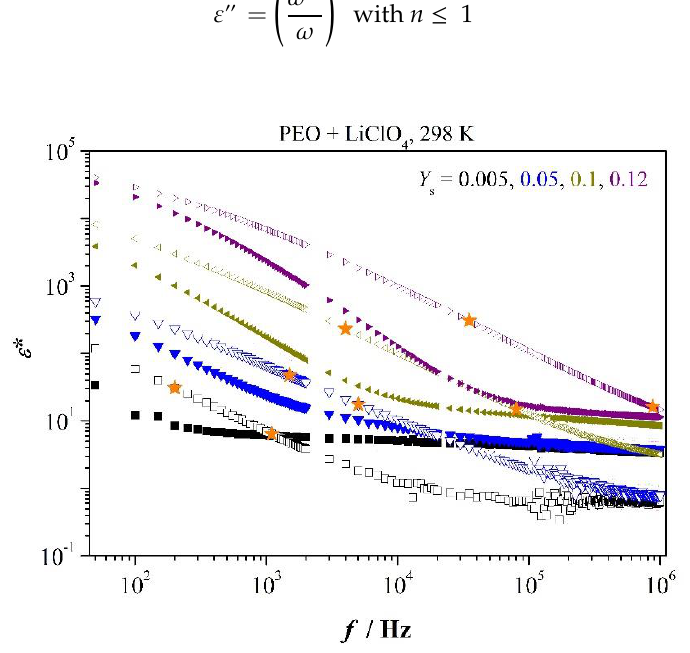
Figure 6. Selected permittivity spectra for the indicated salt concentration; ε (cid:48) —solid marker; stars mark the low-frequency range f Z